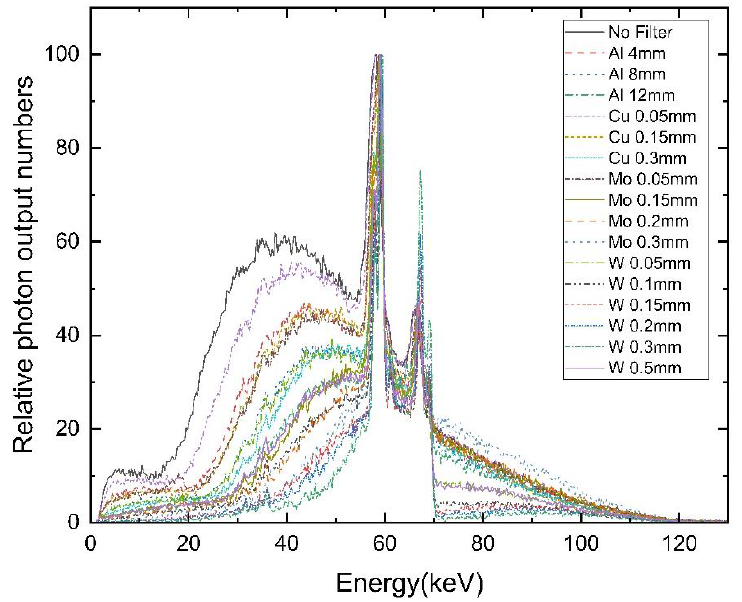
Figure 1. X-ray spectrum from Al, Cu, Mo, W, and no filter at 100 kV. The entrance dose on the X-ray receptor sensor was maintained using the AEC. The experimental results according to the tube voltage and filter thickness are presented in Figure 2a. The dose value of the vertical axis is not an absolute value optimized for pedi- atric chest radiography but a relative value for comparing entrance skin doses by tube voltage and filters. As the thicknesses of the Al, Cu, Mo, and W filters increased, the en- trance skin dose decreased gradually at 100 kVp. Thus, as the thickness of the filter in- creased, the overall entrance skin dose decreased; however, as the tube voltage increased, the dose reduction effect decreased, and when it reached 120 kVp, the entrance skin dose increased. When compared to the tube voltage of 100 kVp, the entrance skin dose was 1.0, in the absence of a filter. The entrance skin dose was reduced as follows: Al 4 mm, 0.77; Cu 0.05 mm, 0.85; Mo 0.05 mm, 0.73, and W 0.05 mm, 0.68, indicating that the dose reduc- tion effect of the W filter was the greatest. Figure 2. ( a ) Entrance skin dose result using various filters (Al, Cu, Mo, W, and no filter). ( b ) Effective dose result using various filters (Al, Cu, Mo, W, and no filter) at 60, 80, 100, and 120 kVp. For effective and organ absorbed doses, Monte Carlo simulations were performed using the PCXMC software based on the entrance skin dose [27–29]. The statistical uncer- tainties of the resulting doses from PCXMC were when the simulation was set to 200,000, and the relative errors were below 5% for organs in the X-ray field [32]. Organ absorbed dose values, such as those in the bones, thyroid, lungs, bone marrow, breasts, testis, and ovaries were obtained using tube voltage, four filters, and no filters in pediatric chest imaging (Figures 2b and 3). For this, the organ absorbed dose calculation by using the PCXMC was applied with the tissue weighting factor presented by ICRP publication 103 [33]. Among children, especially newborns, the risk of increasing organ absorbed doses is high because they are small in body size and are often subject to total body irradiation even when only the chest area requires imaging. Even when the X-ray fields were limited to the chest alone, the lungs and bones had the highest organ absorbed dose, followed by the breast bone marrow and thyroid gland. Depending on the filter type, the effective dose was the highest when the 4 mm Al filter was used, followed by 0.05 mm Cu, 0.05 mm Mo, and 0.05 mm W. Therefore, the W filter had the greatest organ absorbed dose reduction, especially at 60 kVp, compared with the other filter types, and no significant difference